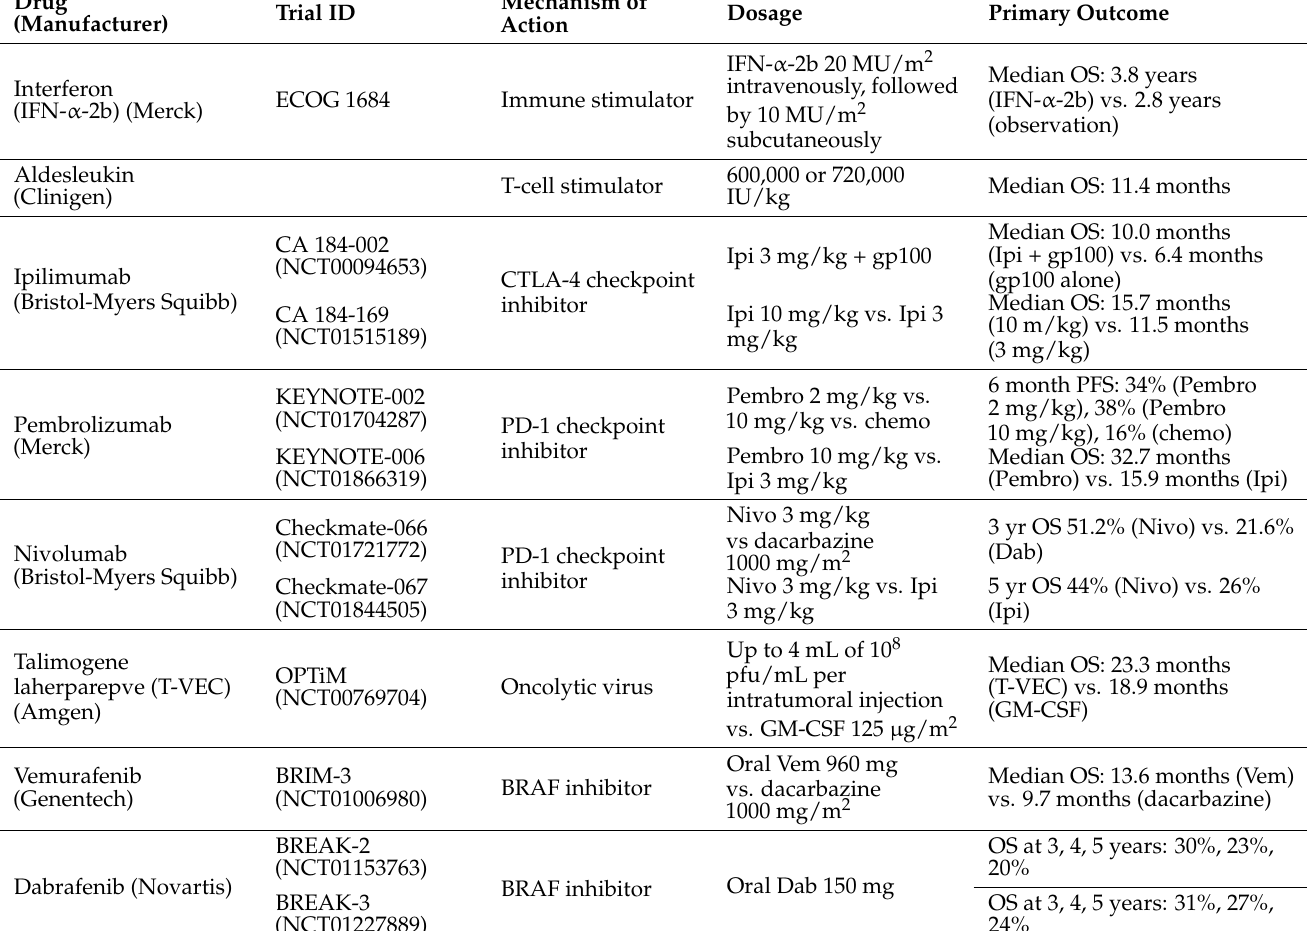
Table 1. FDA-approved monotherapies used to treat stage III/IV